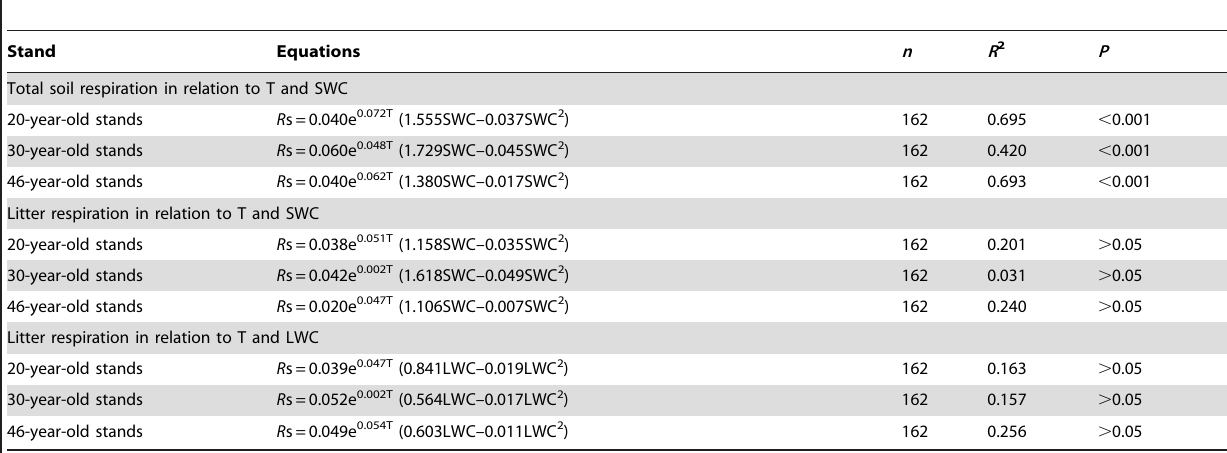
Table 4. The functions and model fit parameters ( n , R 2 and P -values) between measured soil respiration with soil temperature (T), soil moisture content (SWC) and litter water content (LWC) in Pinus massoniana forests.